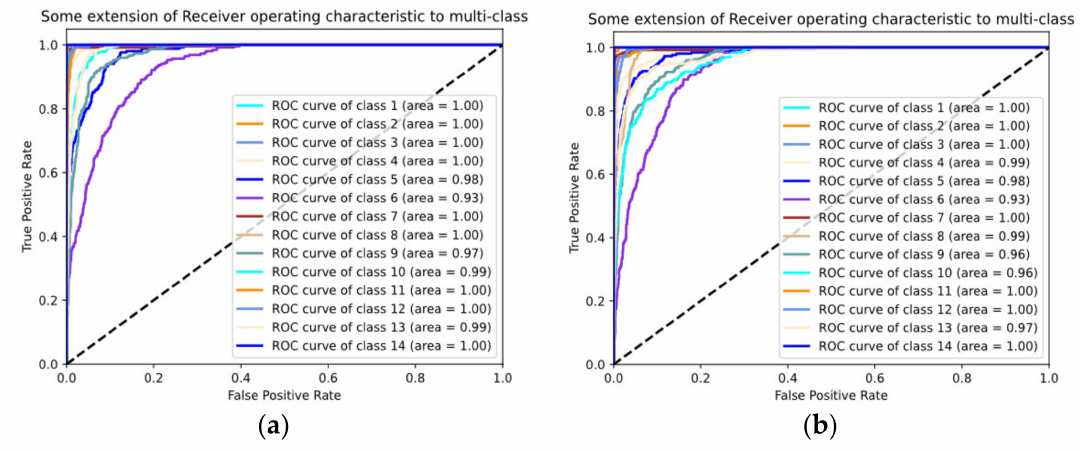
Figure 12. Comparison of ROC curve under Botswana 5% training data: ( a ) CNN spe ( b ) CNN SFMF